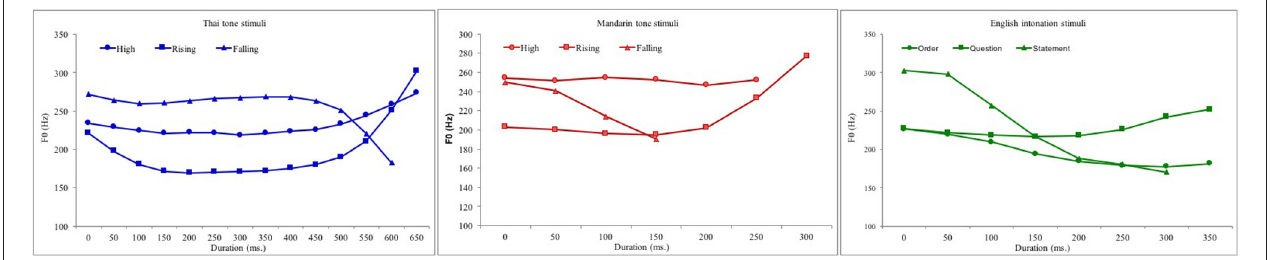
FIGURE 1 | Plots of fundamental frequency (F 0 in Hz) over time (50ms intervals) for the Mandarin (left) , Thai (central) , and English (right) syllables.